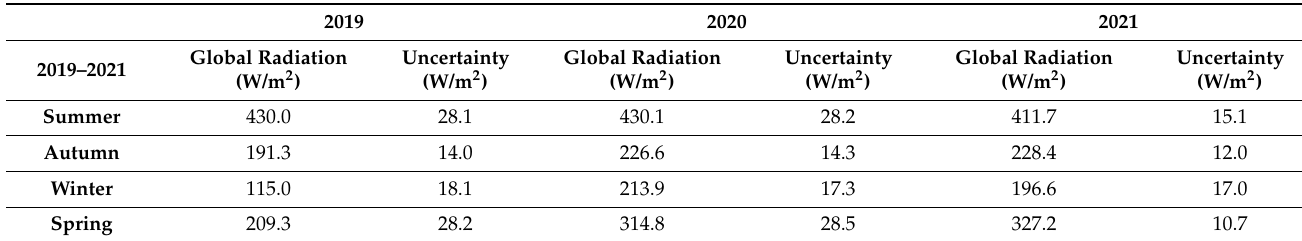
Table 3. Average global radiation registered at the POLITO weather station.